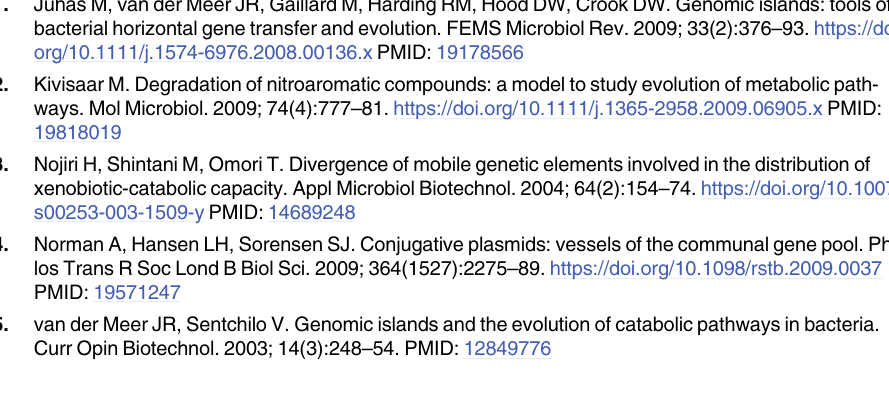
S12 Table. Primers used in the RT-qPCR experiment. S13 Table. Original datasets used to compute